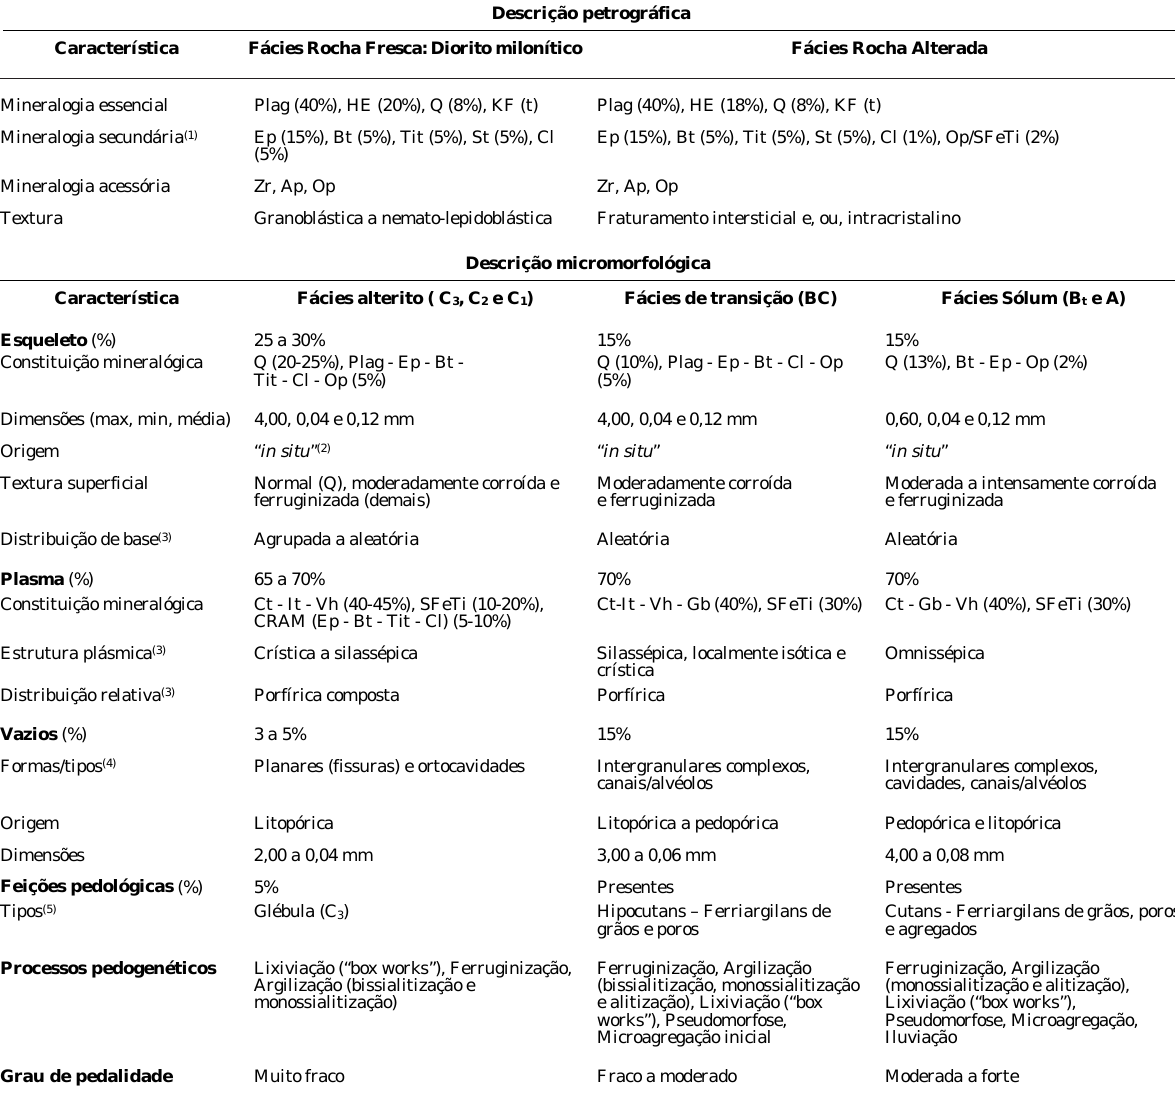
(1) Decorrente de reações mineralógicas retrógradas (hidrotermais ou retrometamórficas). (2) Decorrente de substituições mineralógicas retrógradas. (3) Segundo Stoops & Jongerius (1975). (4) Segundo Brewer (1964) e Pettijohn (1949). (5) Segundo Bullock et al. (1985). Plag = Plagioclásio; HE = Hornblenda-Edenita; Q = Quartzo; KF = Feldspato potássico; Ep = Epidoto; Bt = Biotita; Tit = Titanita; St = Sericita; Cl = Clorita; Zr = Zirconita; Ap = Apatita; Op = Opacos; It = Illita; Ct = Caulinita; Vh = Vermiculita com hidróxi nas entrecamadas; Gb = Gibbsita; SFeTi = Sesquióxidos de Fe e Ti; CRAM = Cristais relictuais à alteração mineralógica; t =